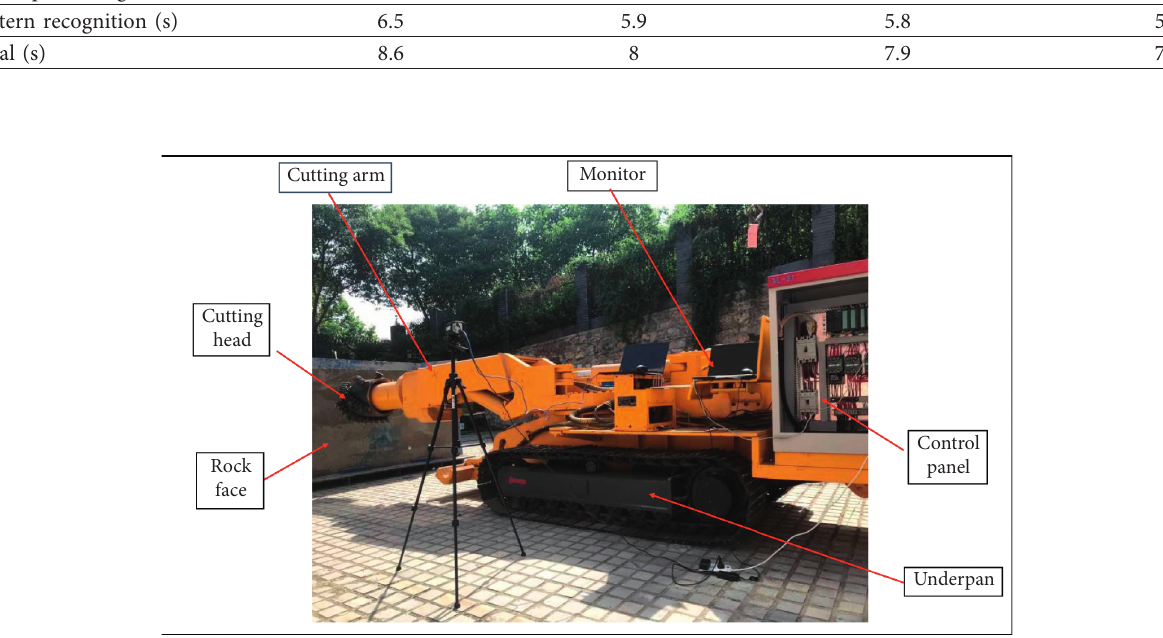
Figure 8: Experimental setup. Table 2: Sample